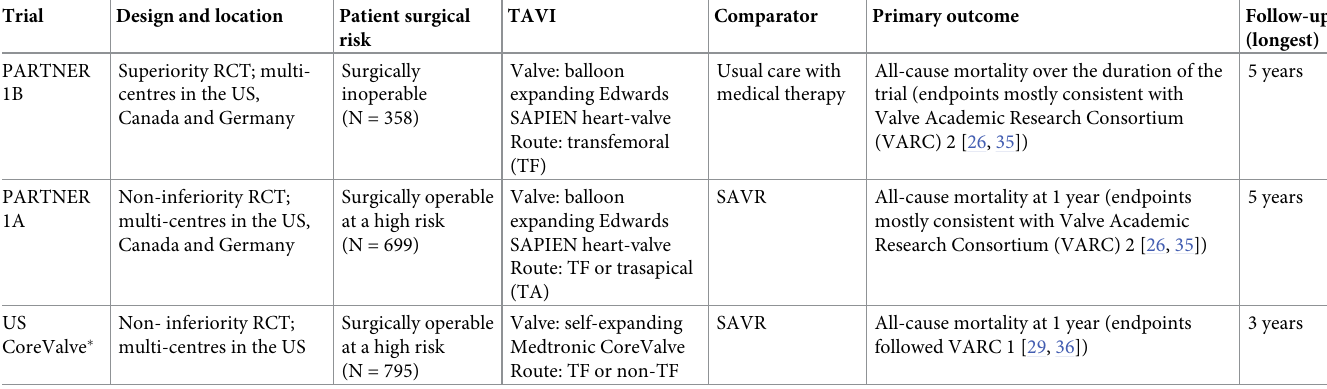
Table 1. Outline of the RCTs included.